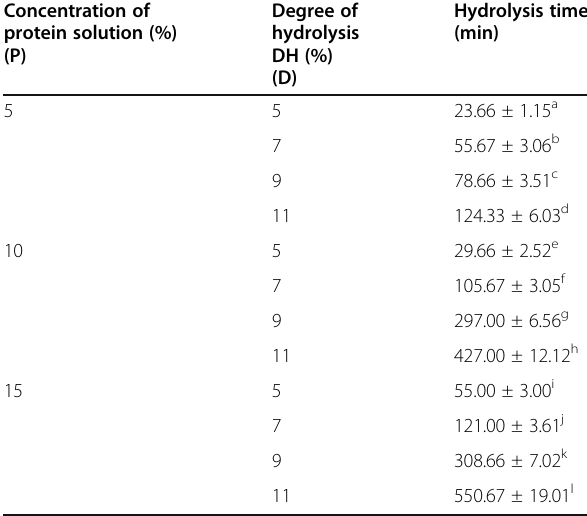
Table 1 Effect of concentration of protein solution and degree of hydrolysis on the hydrolysis times Concentration of protein solution